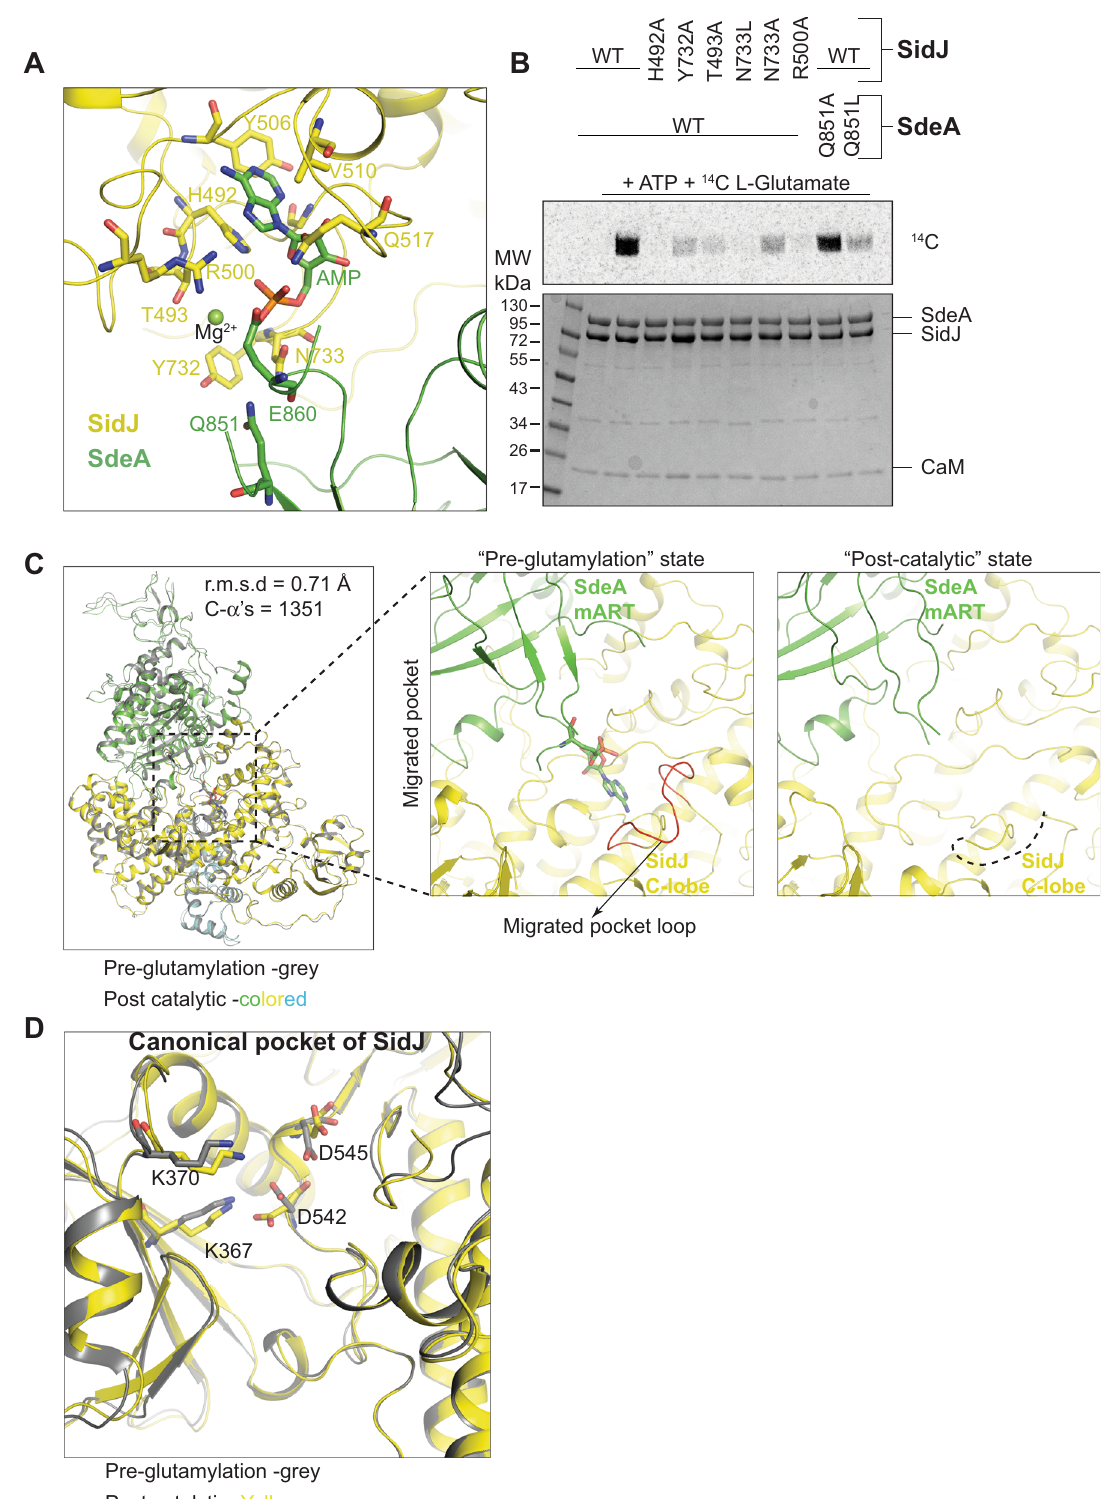
Fig. 4 SidJ catalyzes glutamylation in the migrated pocket. A Detailed view of the SidJ – SdeA Interaction site 3- adenylylated E860 of SdeA (Green) inserted into the migrated pocket of SidJ (Yellow), with key residues shown. B Incorporation of [ 14 C]-Glu into SdeA catalyzed by SidJ using mutations on both SidJ and SdeA from site 3. Samples were separated by SDS-PAGE and visualized by Coomassie stain (Bottom) or autoradiography (Top). C Structural comparison between SidJ E565A (Yellow)/CaM + SdeA (Green) in its pre-glutamylation and post-catalytic states. Highlighted is a loop of SidJ (Red) located in the migrated pocket that undergoes structural change post-catalysis. D Overlay of SidJ canonical pocket in pre-glutamylation (Gray) and post- catalytic (Yellow) state, with key residues